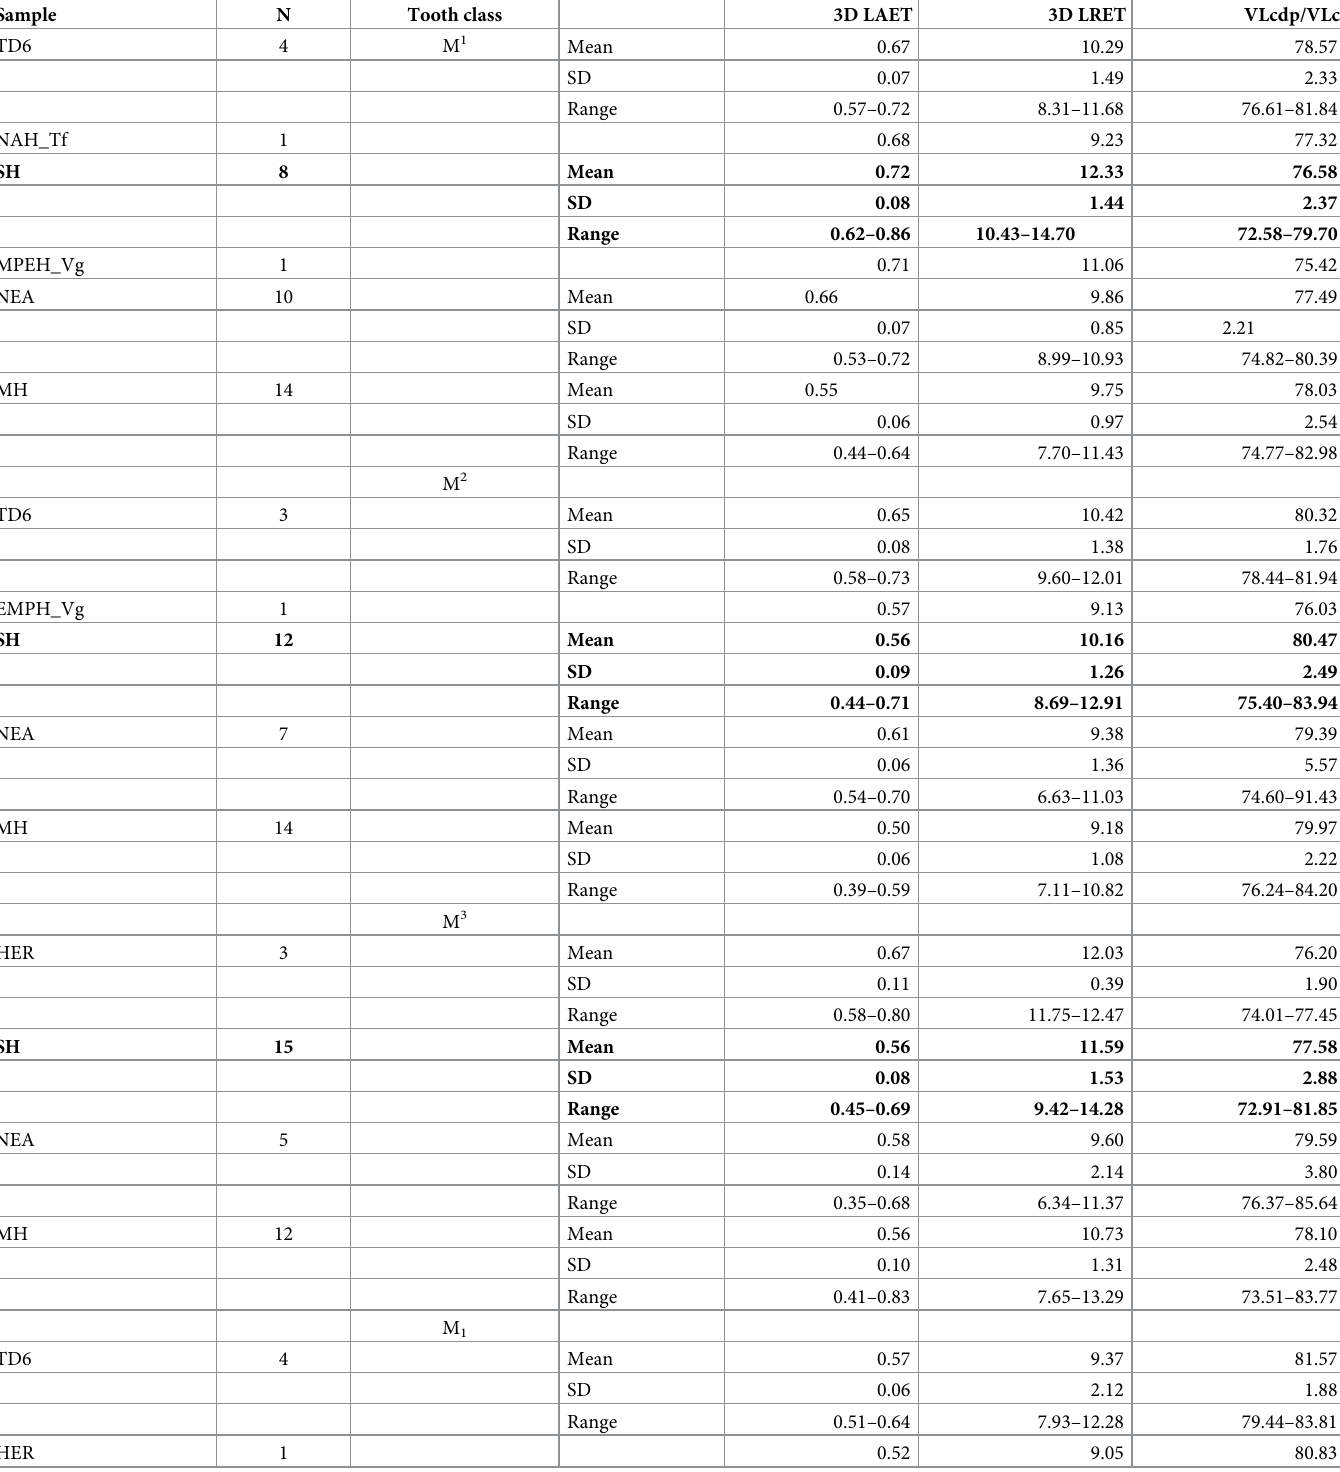
Table 6. 3D lateral enamel thickness variables assessed in SH maxillary and mandibular molars and compared with extinct and extant specimens/populations (SH data in bold). Mean and range are given for the comparative sample when having more than two specimens. Individual values are given for the rest of comparative